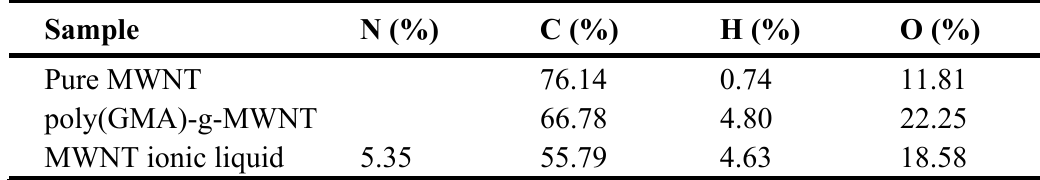
Table 1. Elemental analysis of the prepared MWNT ion